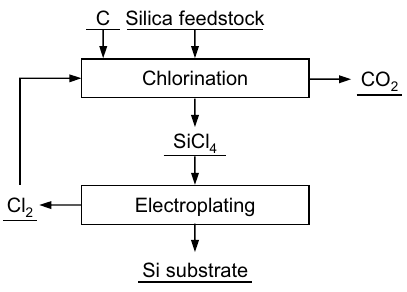
Figure 13: Flowchart for the electroplating in fl uoride – chloride melt and the use of SiCl 4